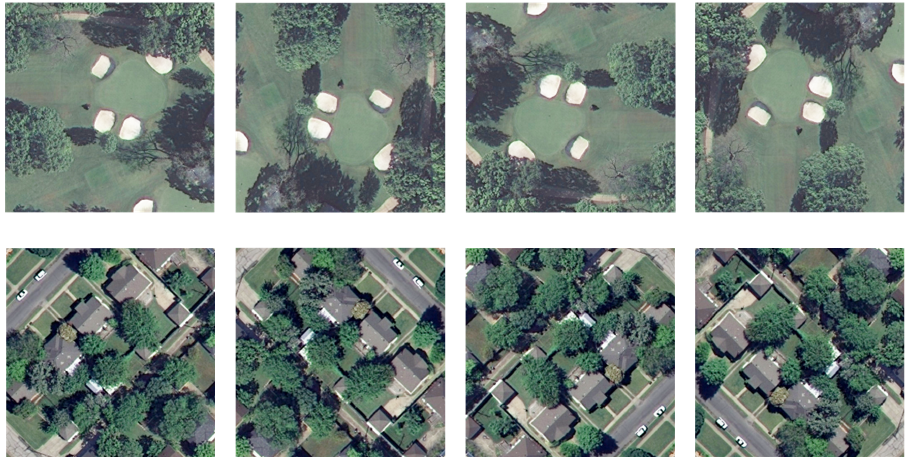
Figure 1. Examples of remote sensing imagery with different